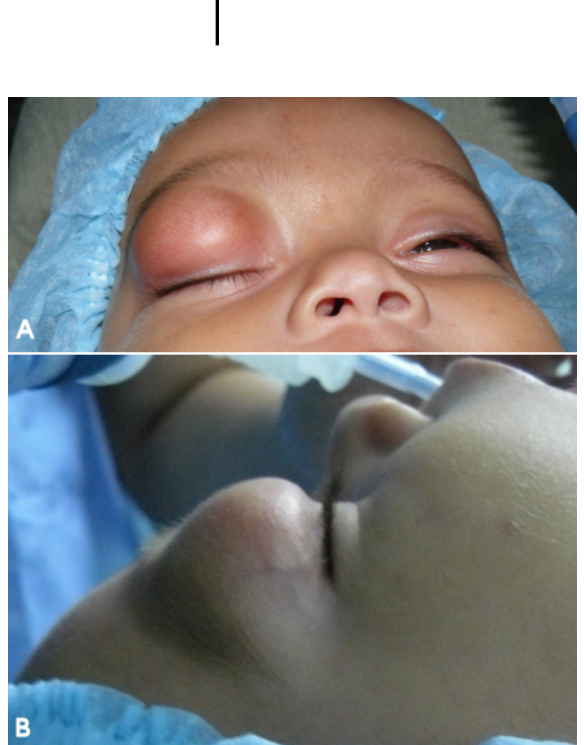
Figure 1: Frontal (A) and lateral (B). Views pre-operatively showing a right upper eyelid mass. Note that overlying skin is not erythematous, edematous or